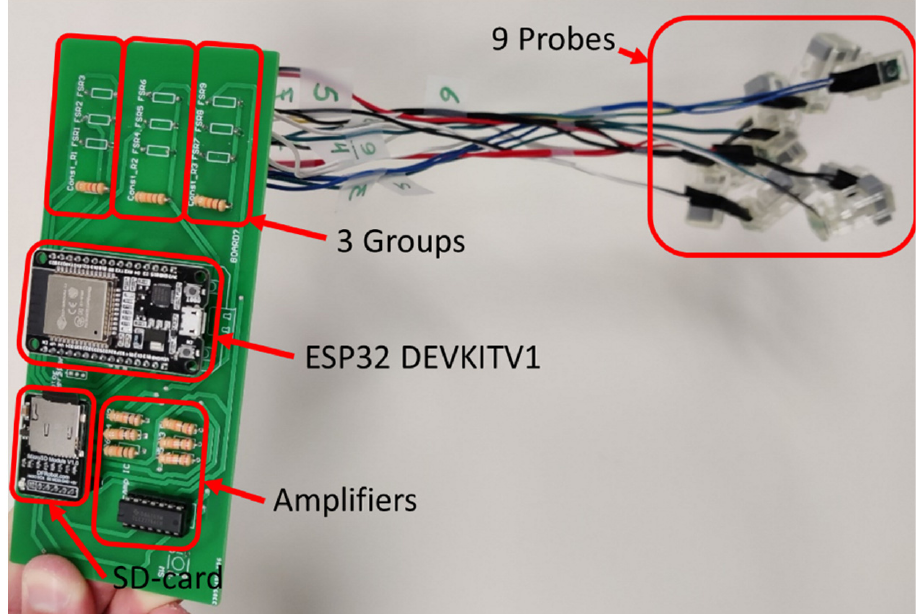
Figure 12. PCB for the proposed system with 9 probes connected as 3 groups.